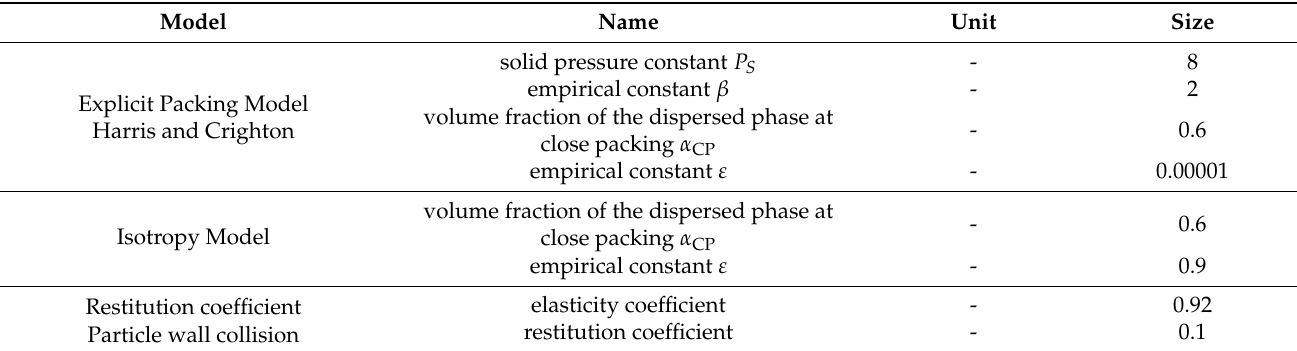
Table 2. Main numerical